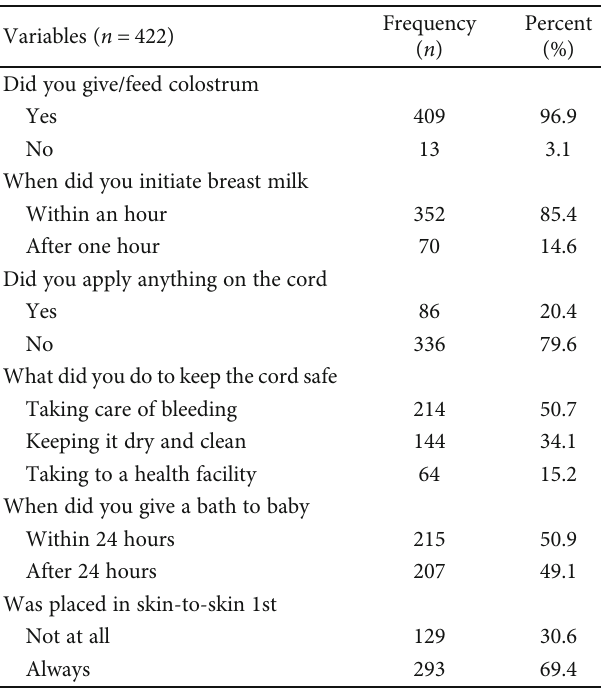
Table 3: Practice of initiation of breastfeeding, cord care, and thermal care of mothers with babies of one-month-old in Hossana town, southwest Ethiopia, 2018 ( n = 422 ).